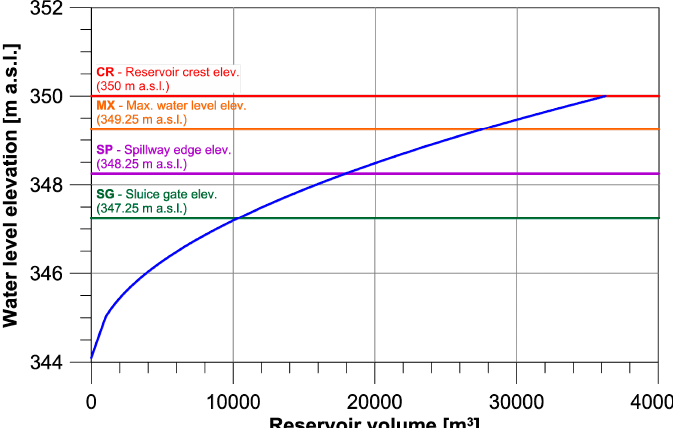
Figure 2. A schematic cross-section of the embankment dam of the Vrbovce small water reservoirs (SWR).